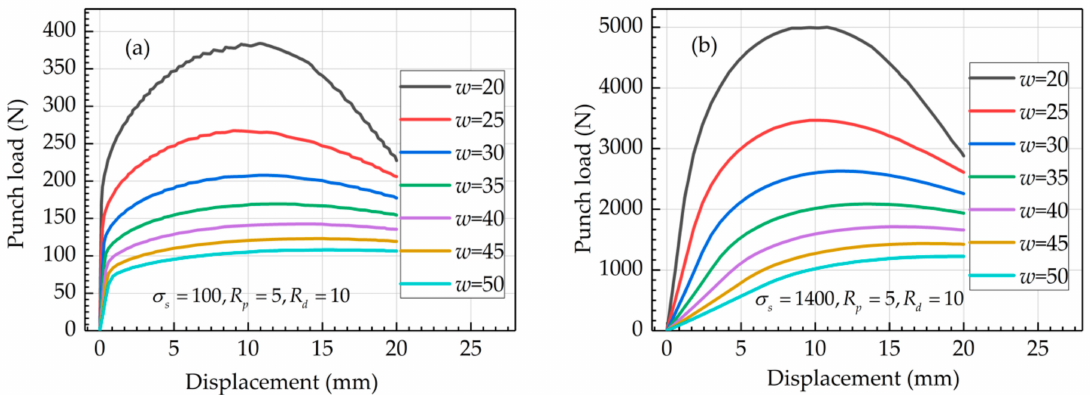
Figure 3. Stroke curve of bending force under di ff erent die spans: ( a ) MYL; ( b ) MYH .